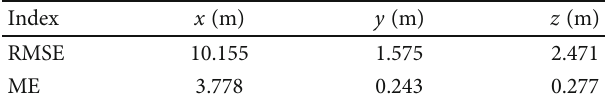
Table 3: RMSE and ME of position loop.